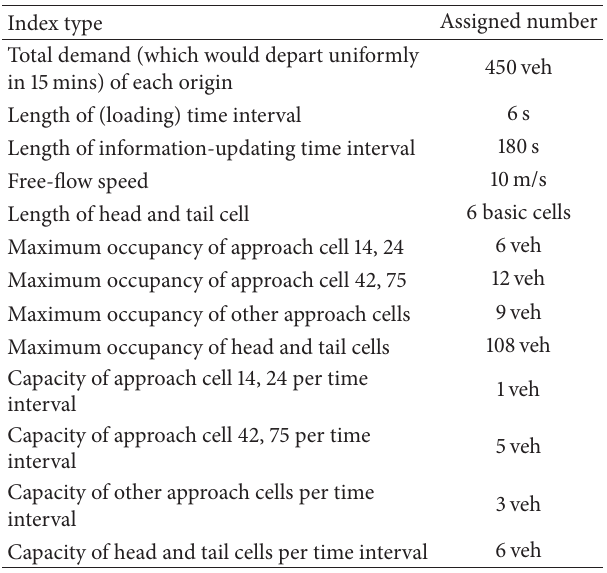
Table 1: Traffic demand and characteristics of